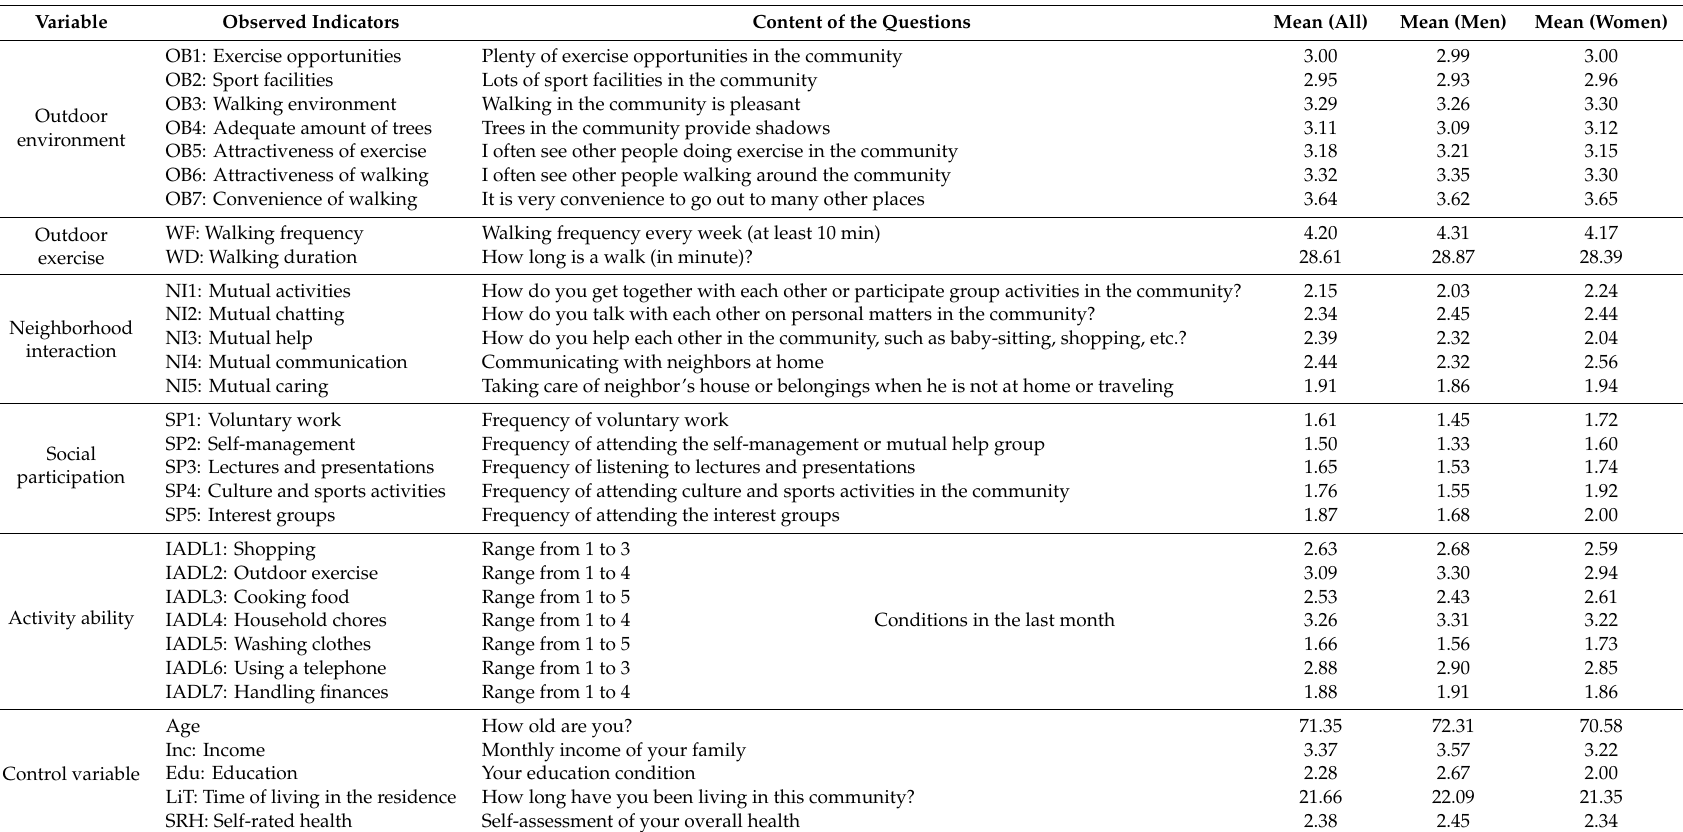
Table 2. Characteristics of